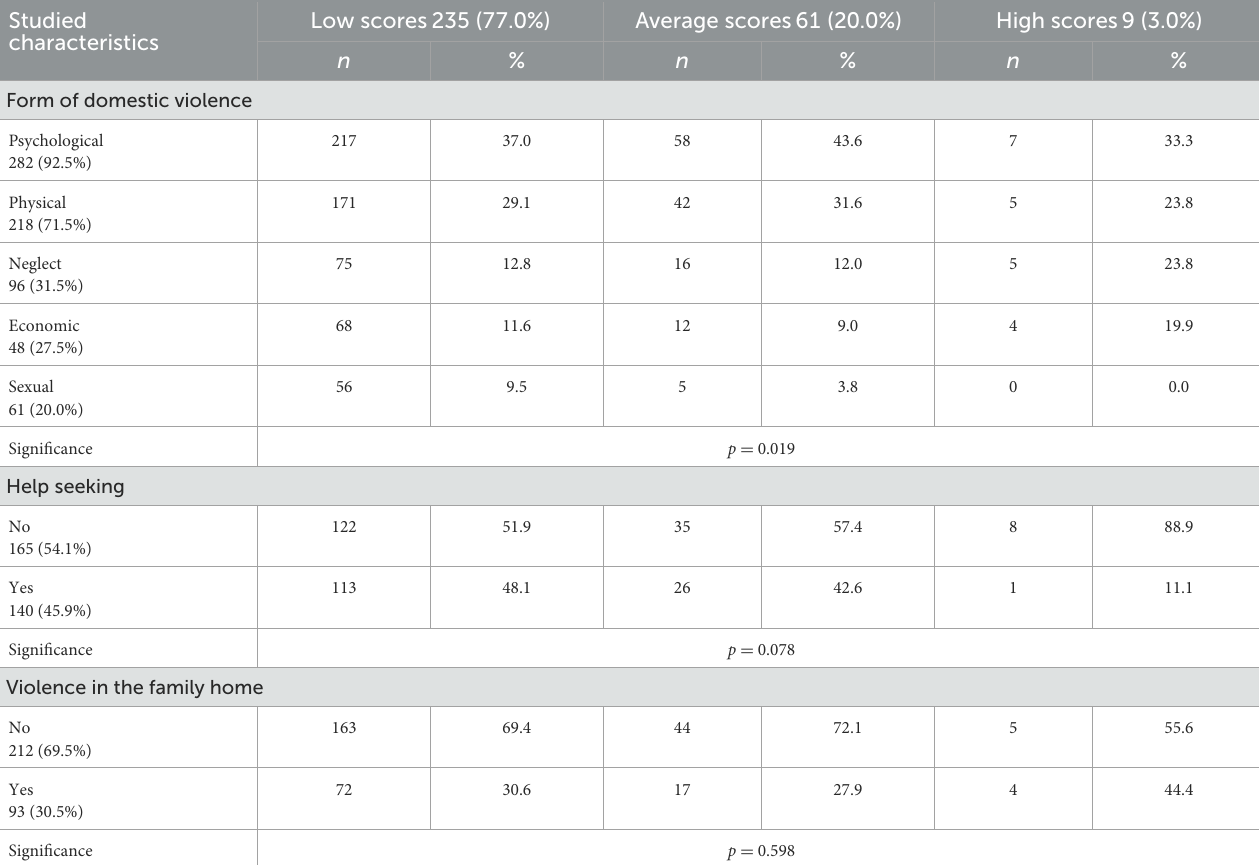
TABLE 6 Satisfaction with life vs. study participants characteristics. Studied